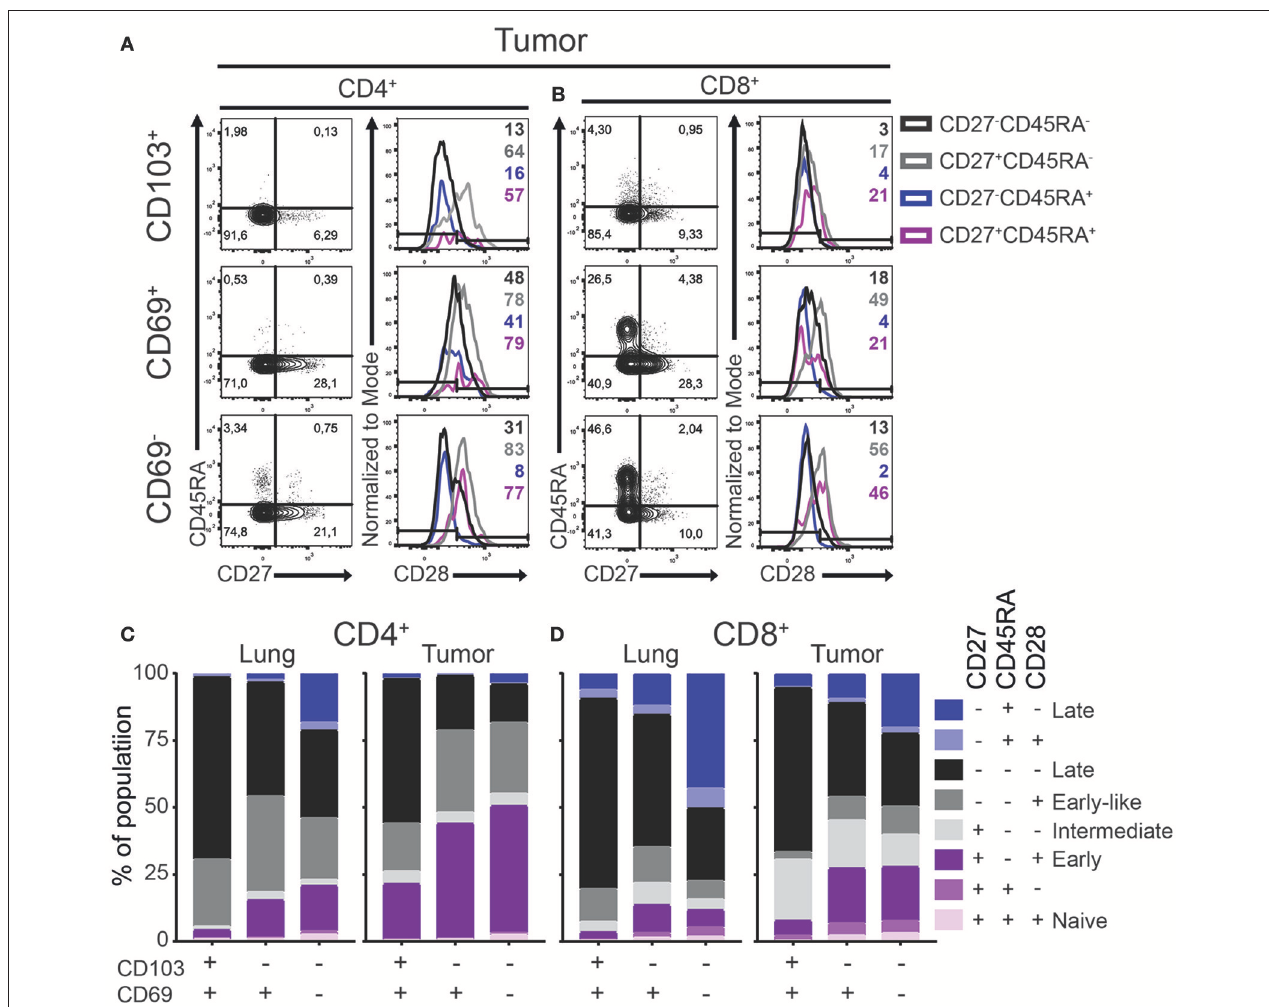
FIGURE 2 | Differentiation status of lung T RM and TILs. (A–D) The expression of CD45RA, CD27, and CD28 on CD4 + and CD8 + lung T RM and TILs was determined. (A,B) The expression of CD27, CD45RA, and CD28 tumor CD103 + (top panels), CD69 + (middle panels), and CD69 − (bottom panels) CD4 + (A) and CD8 + (B) T cells shown by representative contour plots (CD45RA on y-axis, CD27 on x-axis) and histograms overlays (maximum set to 100%) show the expression of CD28 on the different subsets (black CD27 − CD45RA − , gray CD27 + CD45RA − , blue CD27 − CD45RA + , purple CD27 + CD45RA + ). (C,D) The frequencies of CD27 + CD45RA + CD28 + (light purple), CD27 + CD45RA + CD28 − (medium purple), CD27 + CD45RA − CD28 + (dark purple), CD27 + CD45RA − CD28 − (light gray), CD27 − CD45RA − CD28 + (medium gray), CD27 − CD45RA − CD28 − (black), CD27 − CD45RA + CD28 + (light blue), CD27 − CD45RA + CD28 − (dark blue) of CD103 + , CD69 + , and CD69 − lung CD4 + ( C ; left bar graph), tumor CD4 + ( C ; right bar graph), lung CD8 + ( D ; left bar graph), and tumor CD8 + ( D ; right bar graph). (C,D) The quantifications are shown as bar graphs with the mean. n =